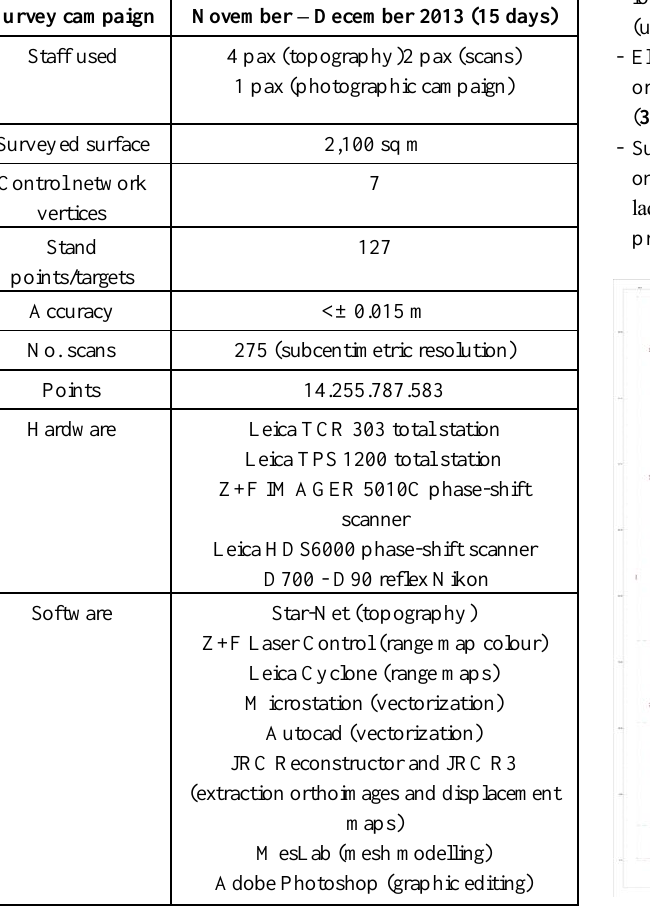
Table 3. Work summary Figure 4. Longitudinal section: vectorial drawing and